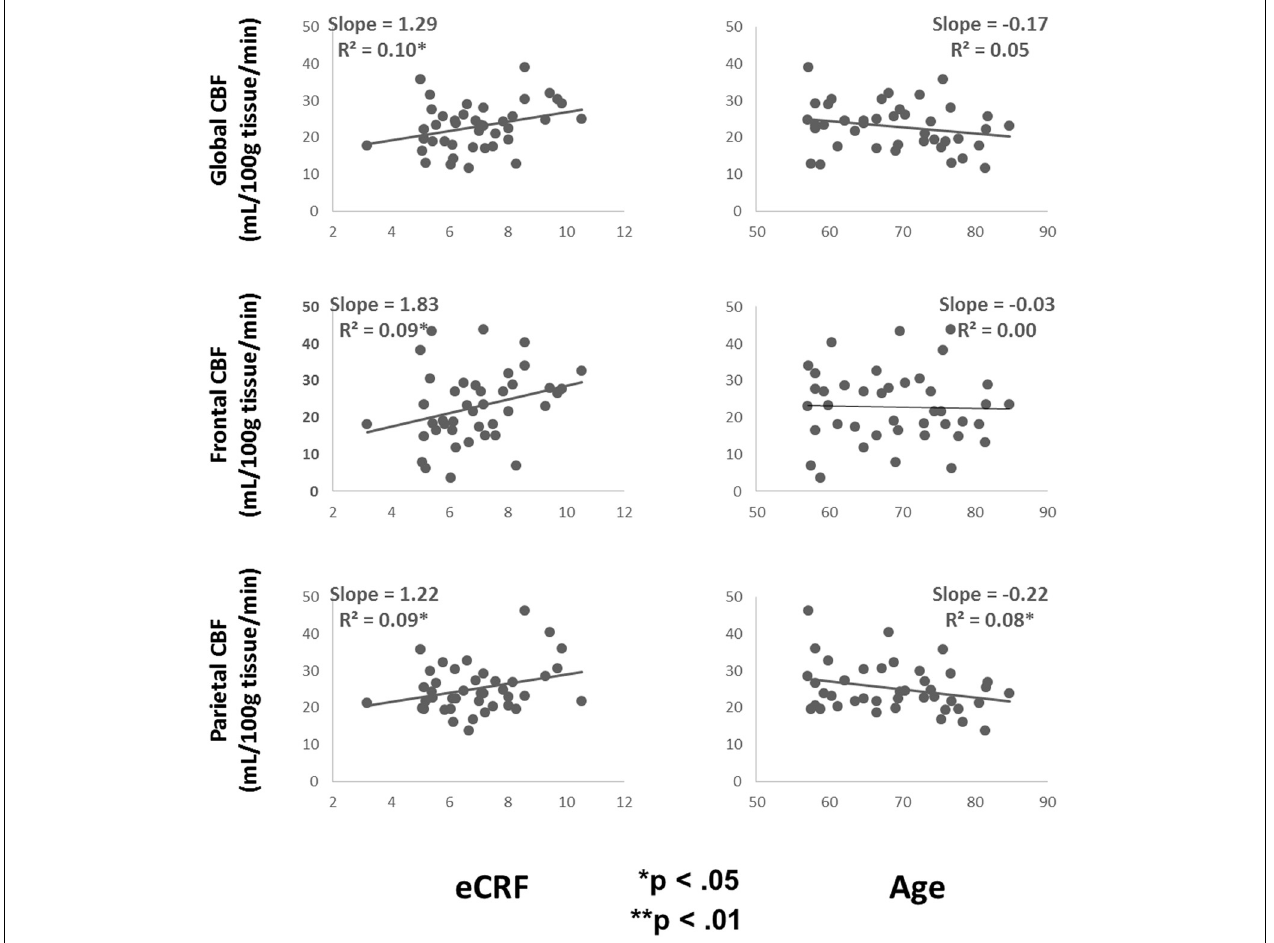
FIGURE 4 | Scatter plots depicting the relationships between CBF and eCRF (left column) and age (right column) in global (top), frontal (middle), and parietal (bottom) white matter regions of interest.